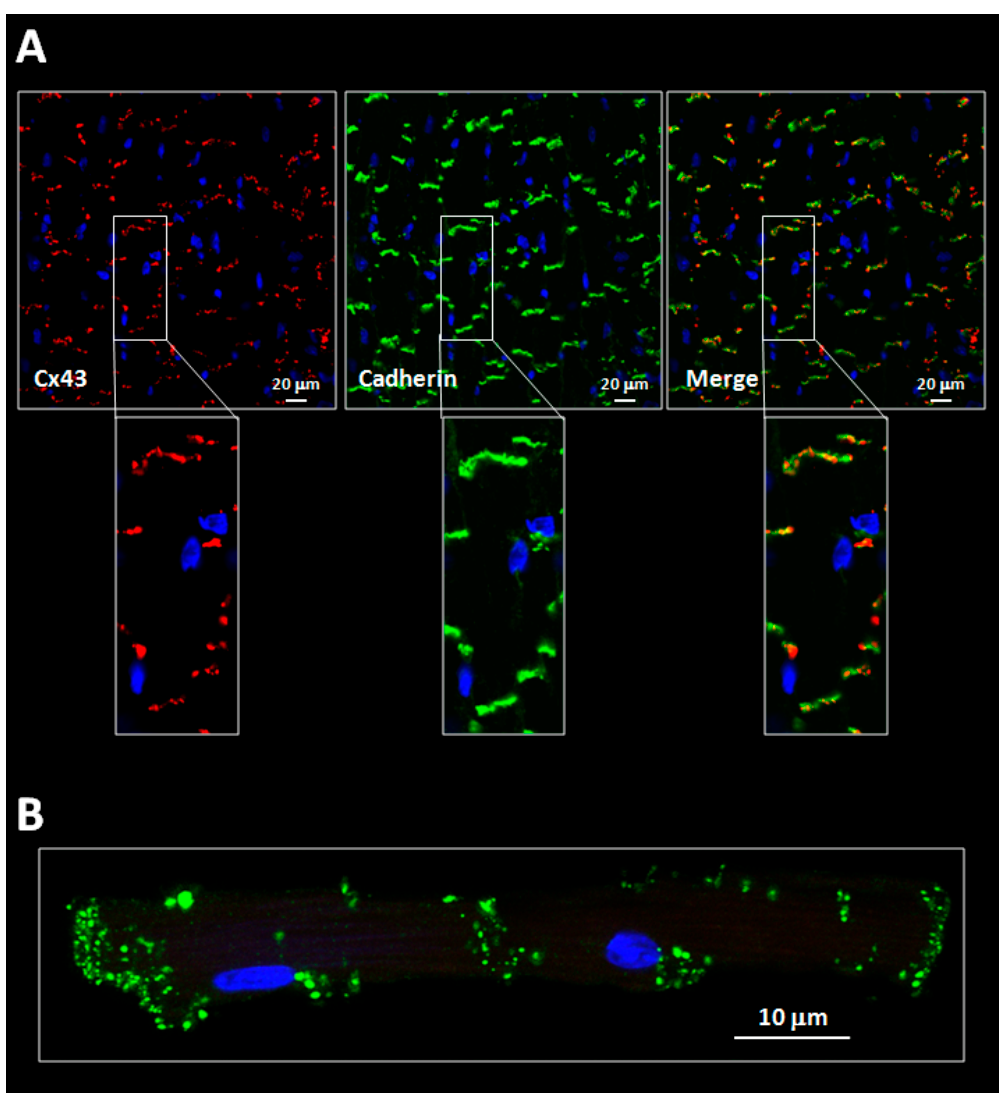
Figure 2. ( A ) Confocal images showing expression of connexin 43 (Cx43, red) in cardiac slices obtained from wild-type mice hearts. Cx43 is mostly expressed at the cell poles, within the intercalated discs, where it colocalizes with pan-cadherin (green) (see magnified images). ( B ) Confocal image of a pair of end-to-end connected mice cardiomyocytes showing Cx43 expression (green) at gap junctions. Nuclei were stained with Hoechst 33642 (blue).